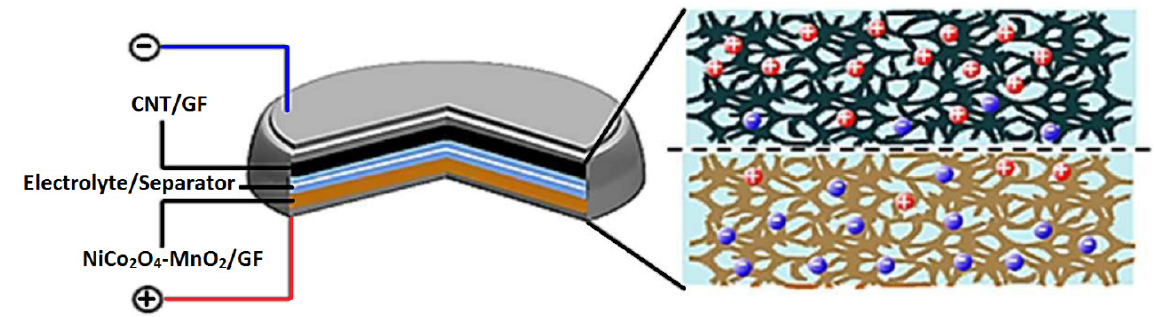
Figure 11. Schematic of the designed asymmetric coin supercapacitor. Reprinted with permission from ref. [68]. Copyright 2017 The Royal Society of Chemistry.